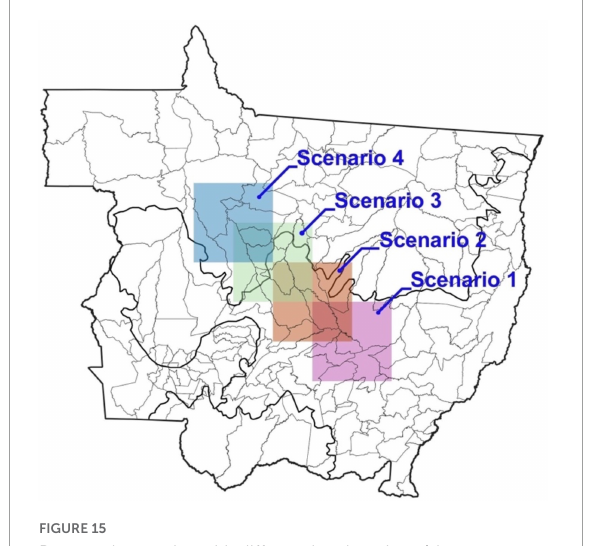
FIGURE15 Proposed scenarios with different box locations (shape 200 × 200).